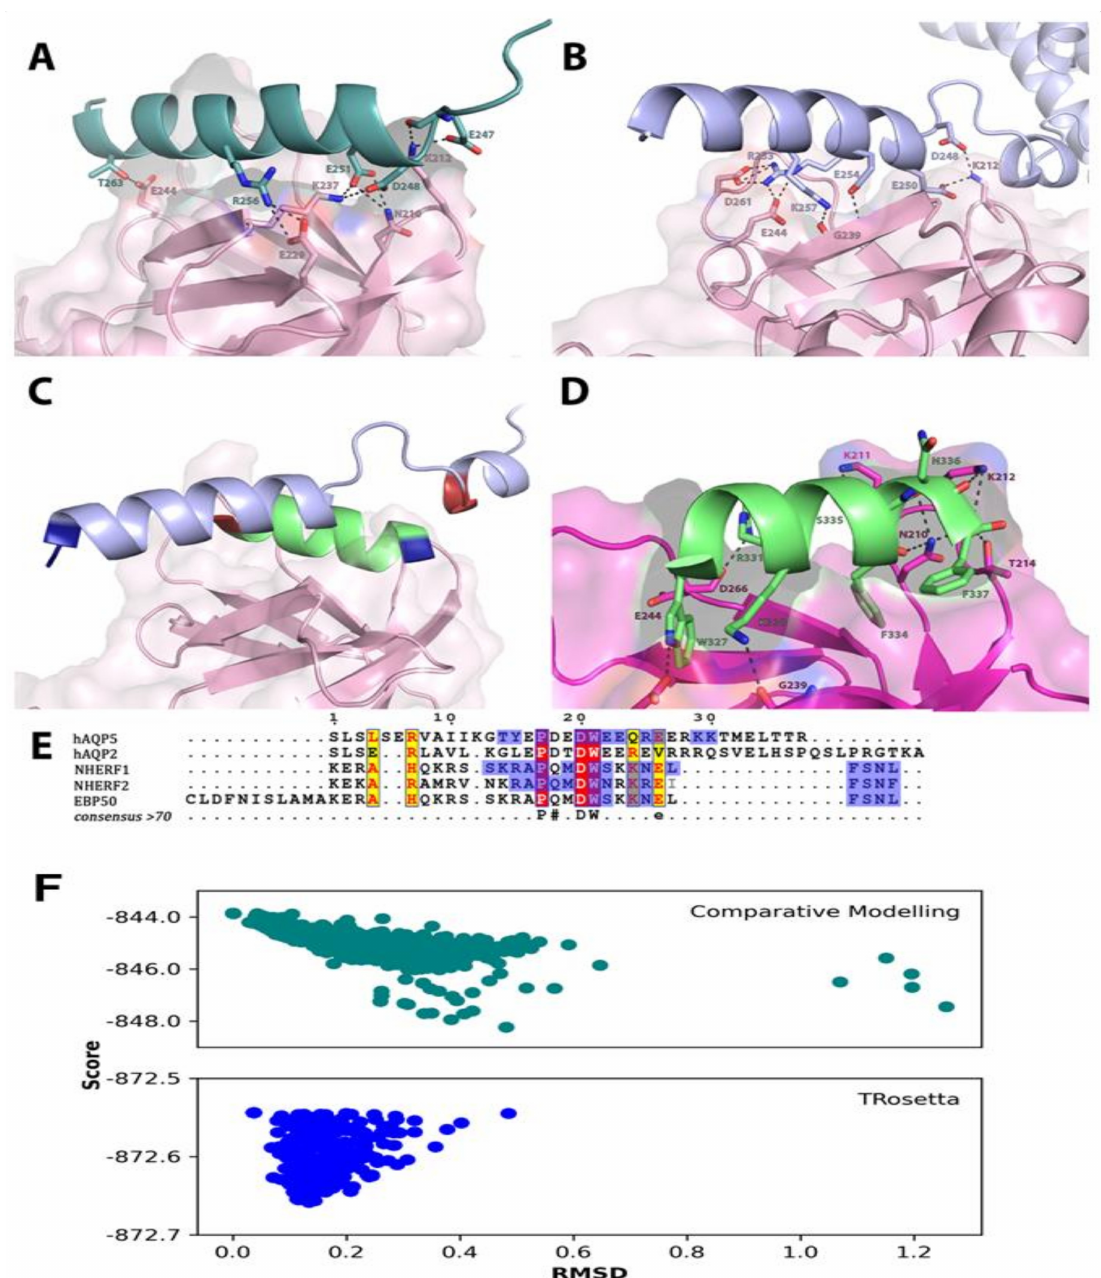
Figure 2. ( A ) Docking solution for complex between AQP5 C-terminus (model 1) and human ezrin FERM domain (PDB code 1NI2) in pink. Residues predicted to form polar contacts by PyMOL are shown with hydrogen bonds as dotted lines. ( B ) AQP5 C-terminus (model 2) by TrRosetta shown in blue. ( C ) Overlay of the AQP5 C-terminus model 2 (blue) with complex between the NHERF-2 C-terminal peptide (green) and the radixin FERM domain (magenta) (PDB code 2D11). The N-and C-termini of the peptide binding regions are shown in blue and red, respectively. The peptides bind in a similar way but in the opposite direction. ( D ) Zoom-in on the interaction site in the radixin FERM–NHERF-2 peptide complex showing the involvement of the same residues found in predicted complex between AQP5 model 2 and human ezrin FERM domain. ( E ) Multiple sequence alignment between C-terminus of human AQP5, AQP2, Drosophila NHERF-1 and NHERF-2, and human SBP50. Conserved residues are highlighted in yellow (highly conserved) and red (fully conserved). Residues involved in the interaction with FERM domains are in blue. ( F ) Scoring of initial AQP5–ezrin interactions generated with PyRosetta. Lower score and RMSD are preferred. The best scoring solutions were studied further using HADDOCK